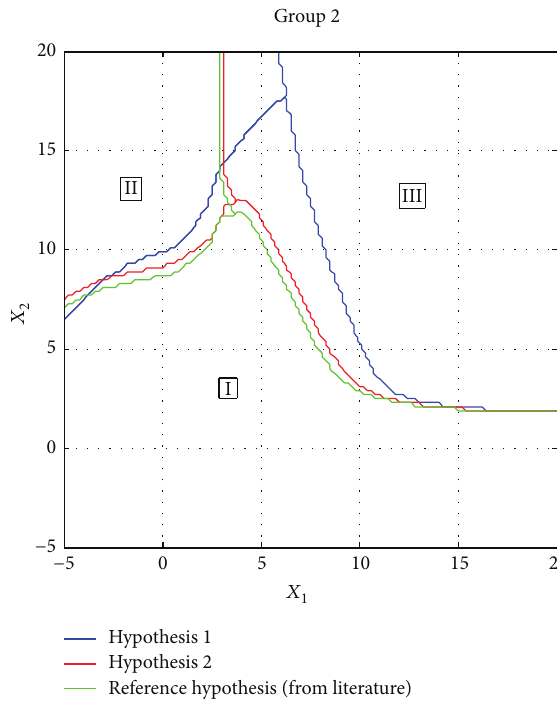
Figure 14: Production policy for 𝑃 2 and setup policy (product 2 to product 1).